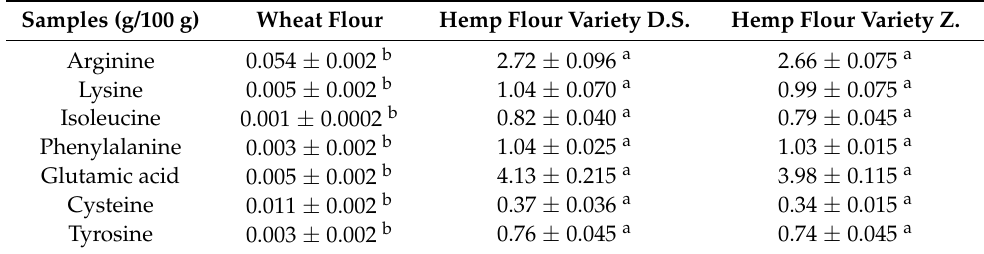
Table 7. The content of amino acids of wheat flour and hemp flour. Samples (g/100 g) Wheat Flour Hemp Flour Variety D.S. Hemp Flour Variety Z.